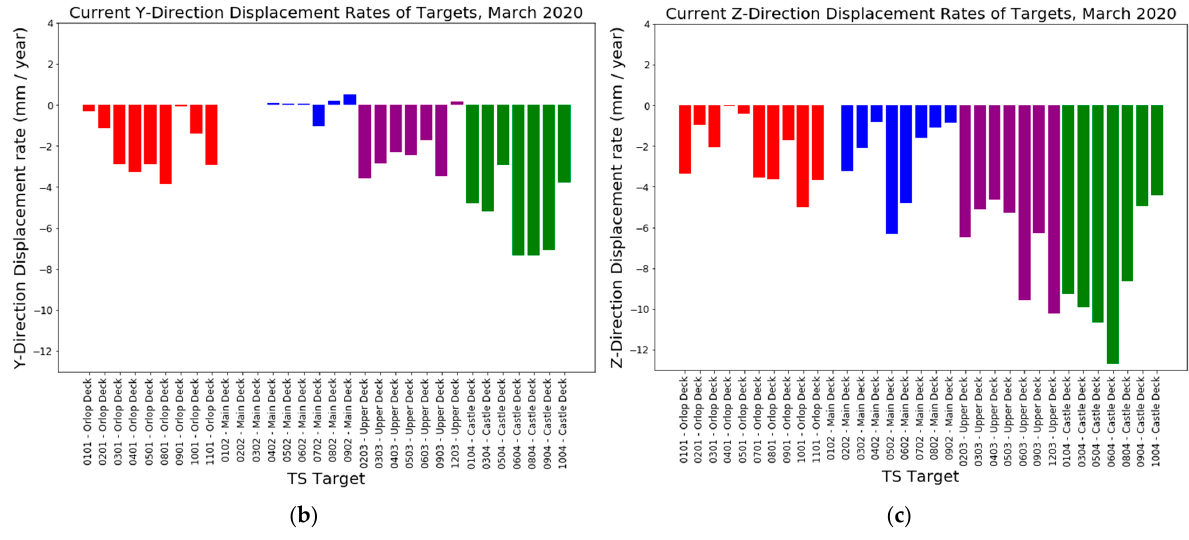
Figure 9. Most recent (2020) displacement rates in the ( a ) X, ( b ), Y and ( c ) Z directions. The colour of the bars denotes the deck on which the target is located: red—orlop, blue—main, purple—upper, green—castle. As a rough selection process for identifying problematic sections, we could investi- gate any targets currently displacing faster than 10 mm/year. From the graphs, the sec- tions with greater than 10 mm/year displacement are 03.04, 05.04 and 06.04. These should be monitored carefully moving forward to ascertain if they will slow down in accordance with the other sections.